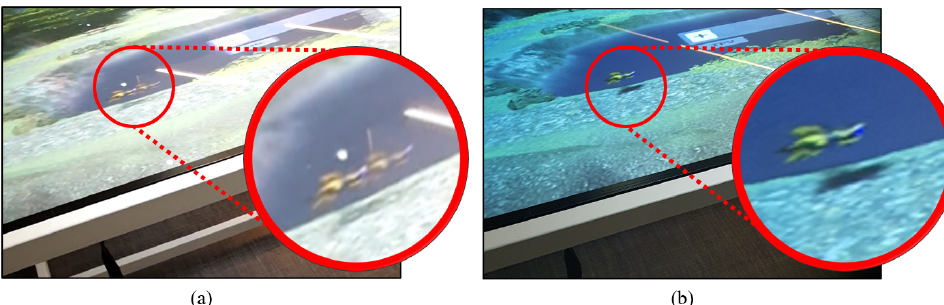
Figure 8. The 3D flight environment on VR table: ( a ) projected by the 3D projector; ( b ) as seen by the user.